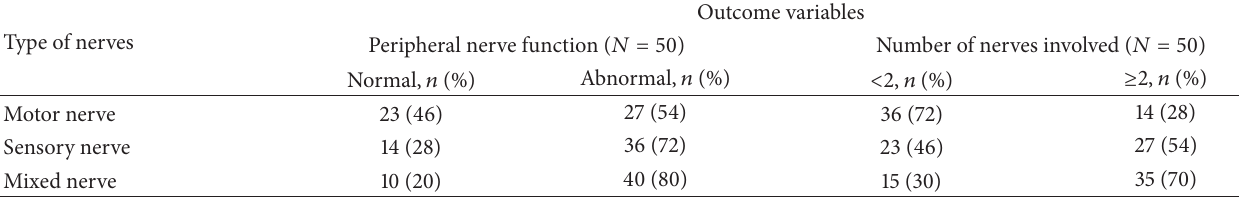
Table 1: Descriptive of outcome variables with nerve function and number of nerves involved in